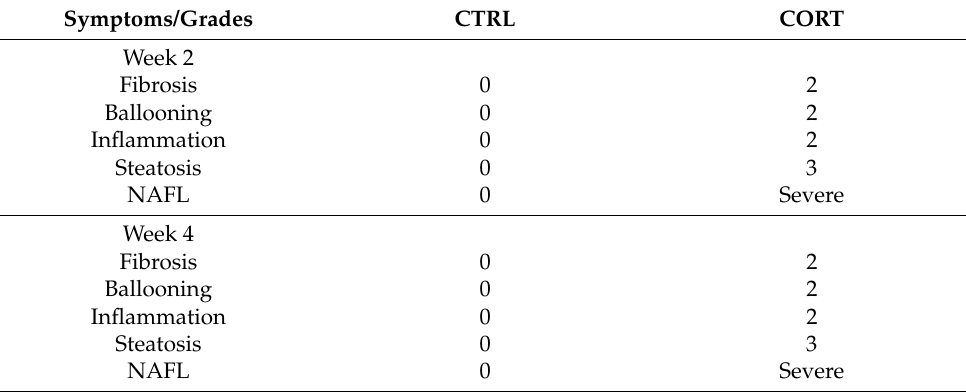
NAFL = non-alcoholic fatty liver. Note: CTRL = control; CORT = corticosterone. Week 4 and 6 of age are equal to 2 and 4 weeks durations of CORT administration to the chicken ( n = 20).